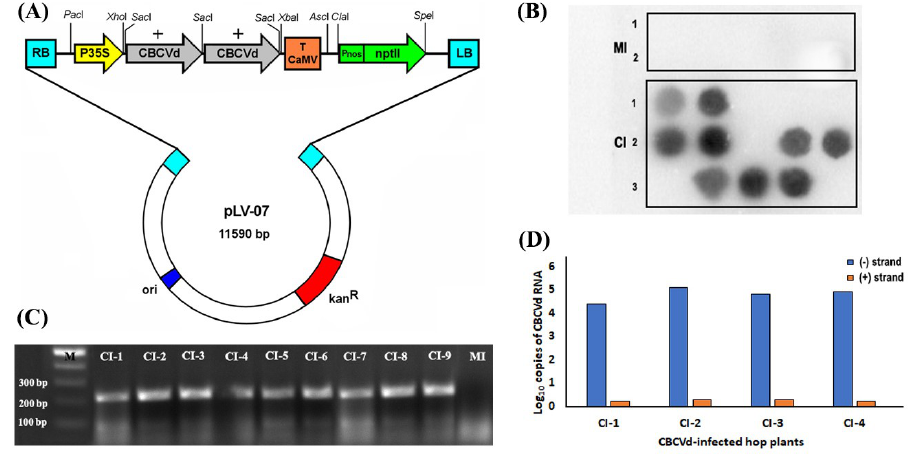
Figure 1. Construction of Citrus bark cracking viroid (CBCVd)-infectious construct and CBCVd detection and quantification: ( A ) Schematic diagram of a plasmid including the CBCVd (+) dimer created by cDNA cloning in Sac I restriction site. The CBCVd (+) dimer was re-cloned from pPCR-Script